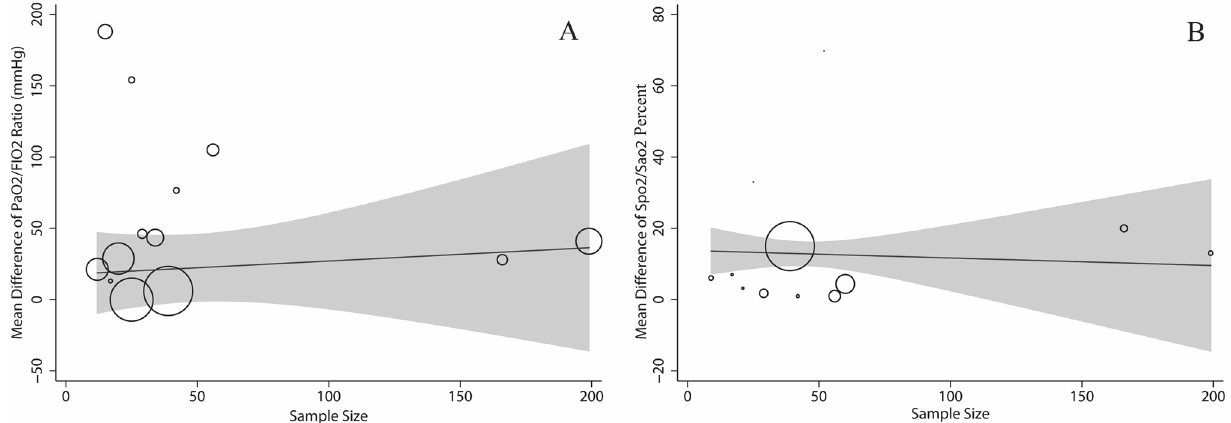
Figure 6. Association between sample size with mean difference (MD) of PaO 2 /FIO 2 Ratio (mmHg) ( A ) and Spo 2 (Sao 2 ) ( B ) using meta-regression. Size of the circles indicates sample magnitude. There was no significant association between sample size with MD of PaO 2 /FIO 2 Ratio and Spo 2 (Sao 2